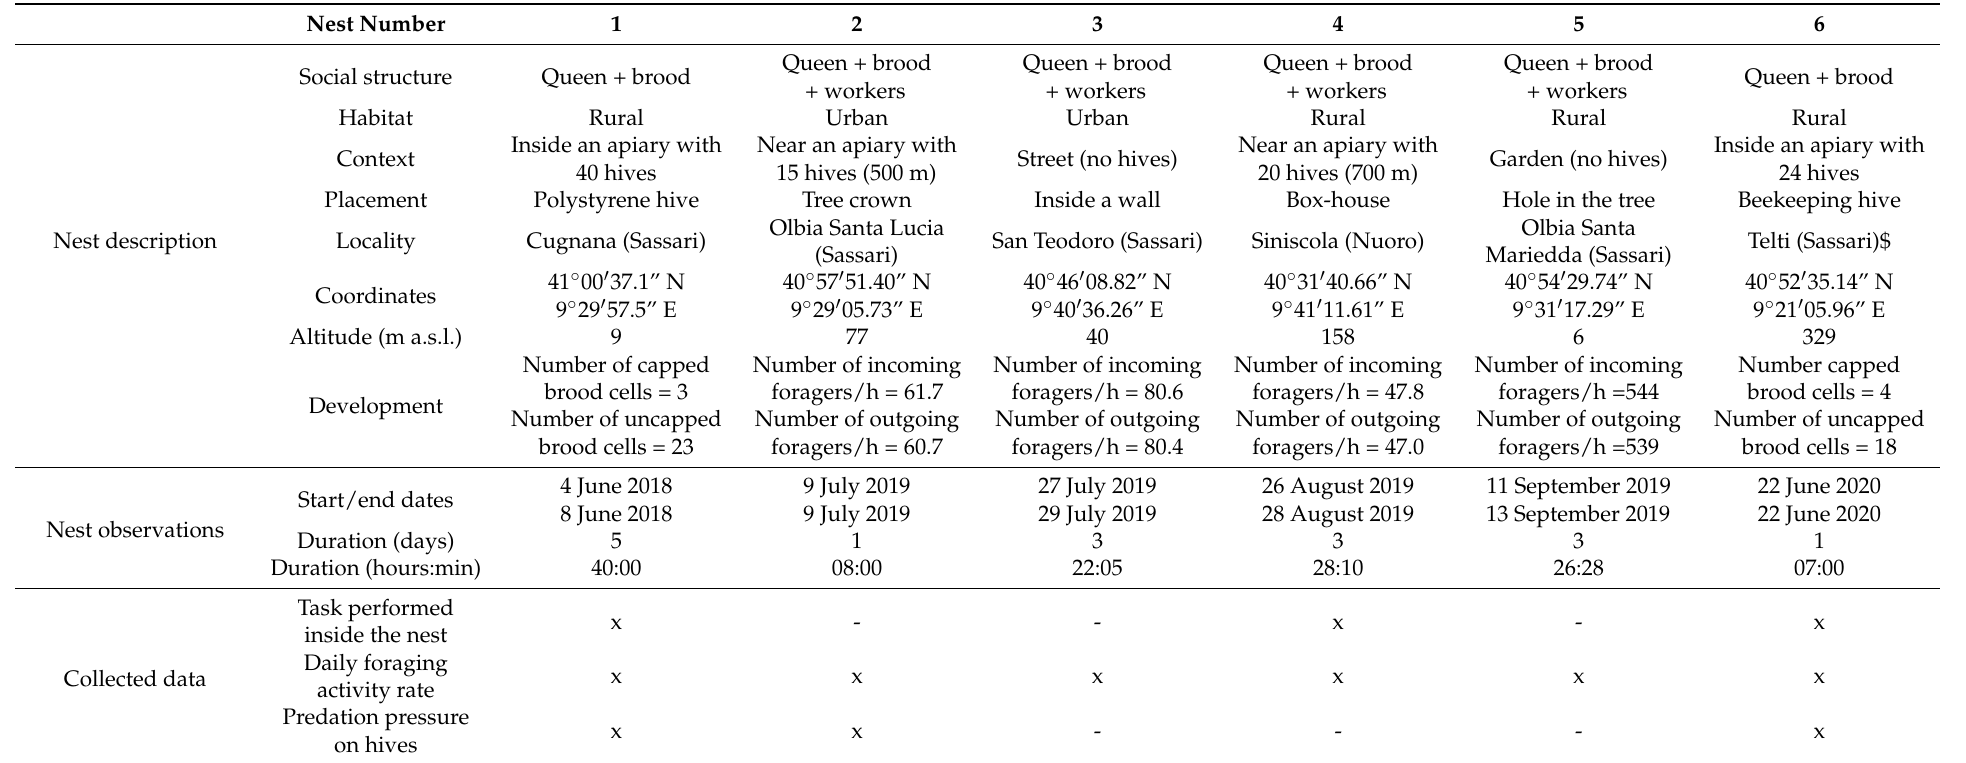
Table 1. Features of the European hornet nests observed, and data collected in north-eastern Sardinia (Italy). Nest